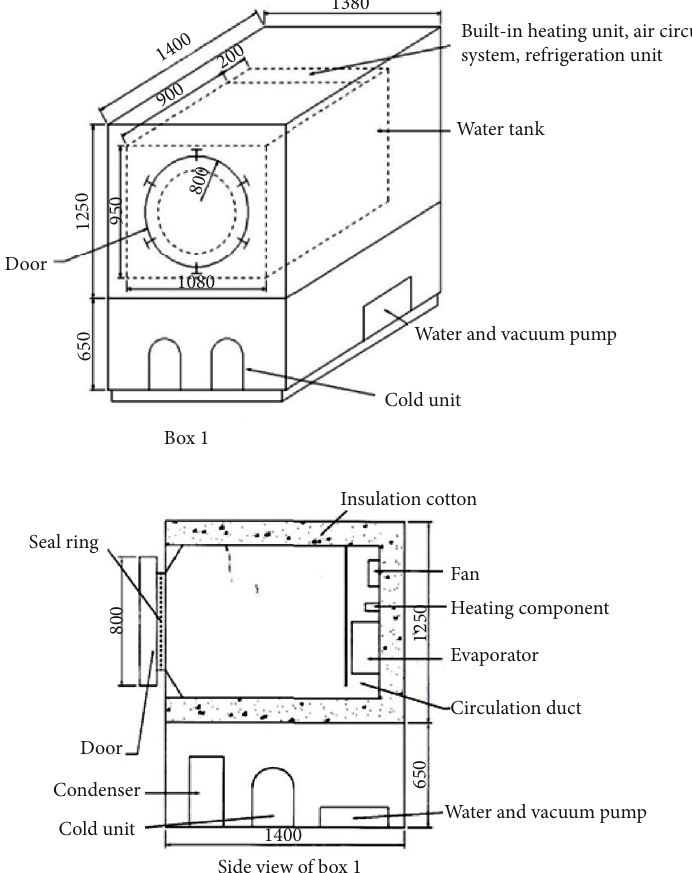
Figure 9: Schematic diagram of temperature and humidity gas mixing chamber